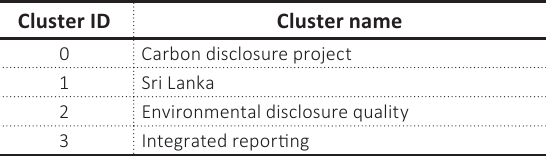
Table 7. Keyword clustering results